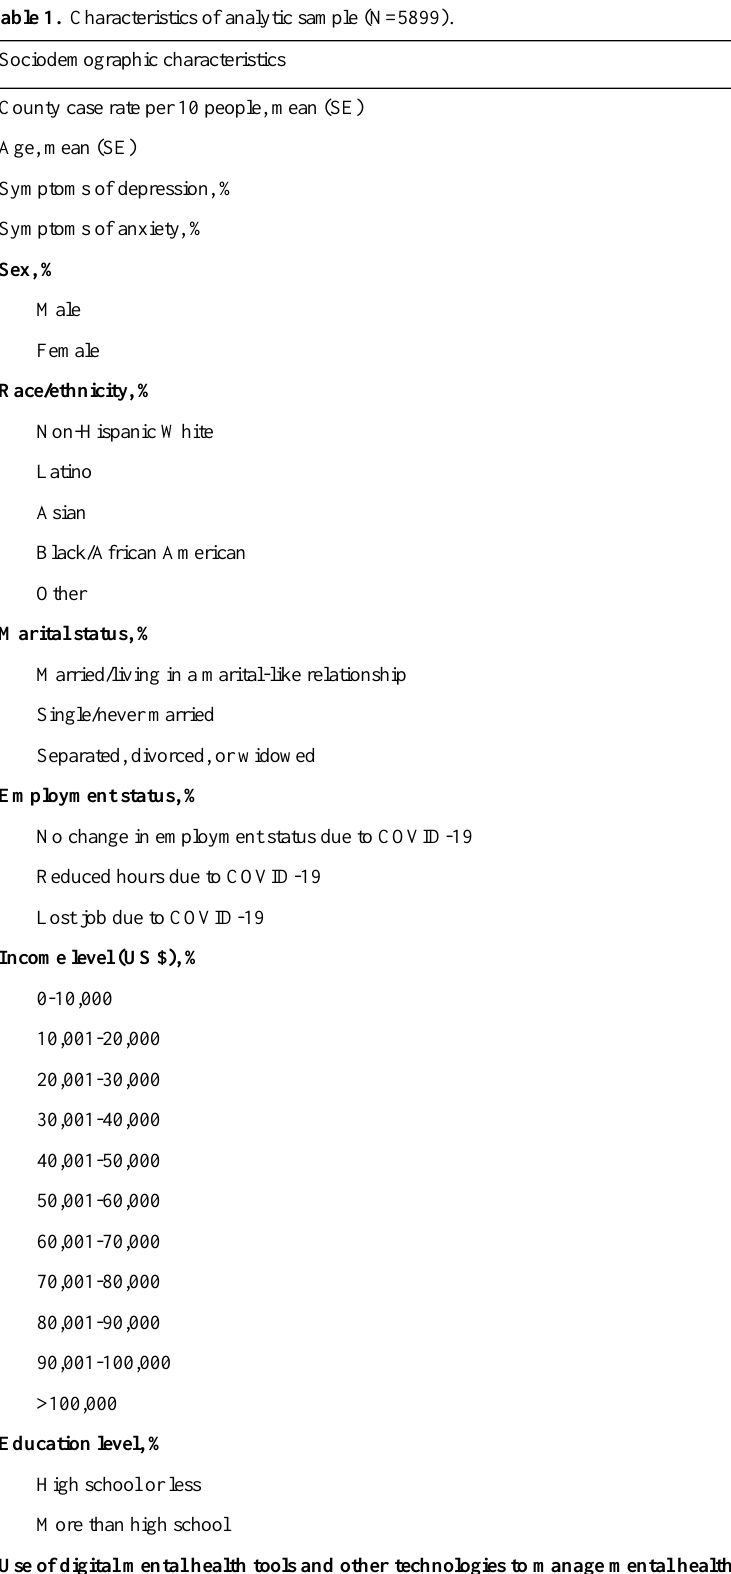
Table 1. Characteristics of analytic sample